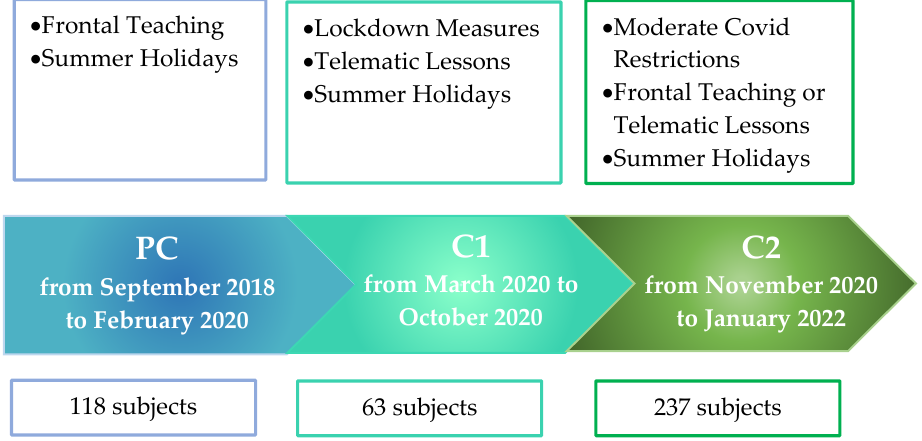
Figure 1. Timeline and periods description. PC: Pre COVID; C1: COVID 1; C2: COVID 2.